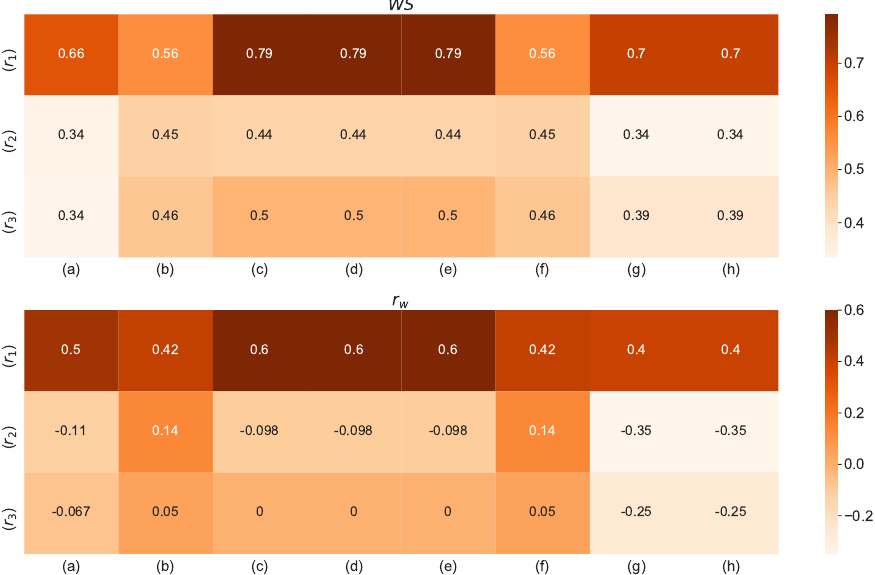
Figure 3. Comparison of r w and WS similarity coefficients [55] between reference rankings ( r 1 ) – ( r 3 ) and rankings obtained by using proposed operators ( a – h